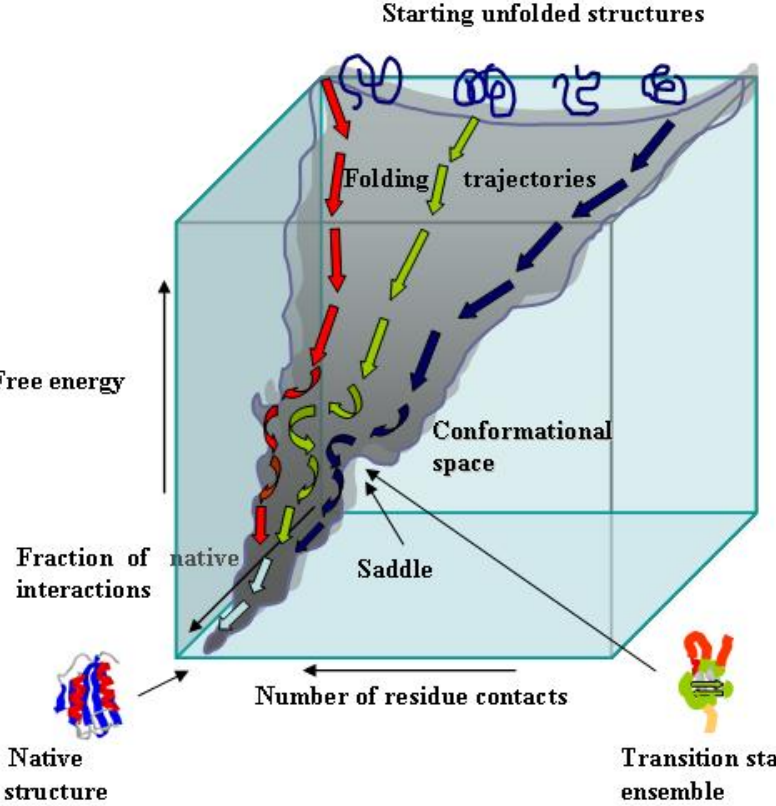
Figure 2. Folding energy